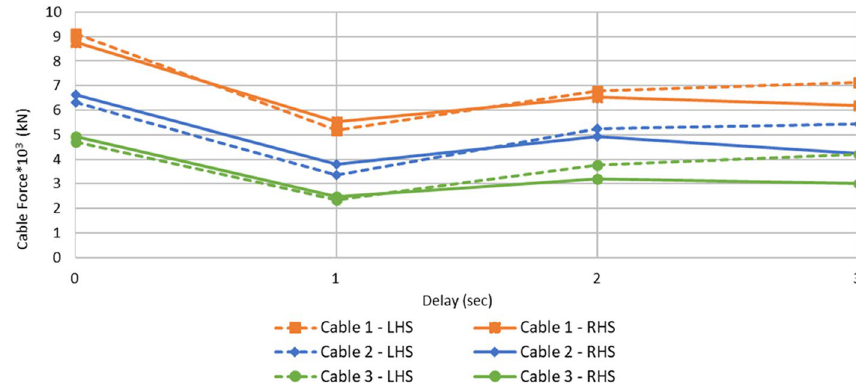
Fig. 16 Average force in cables